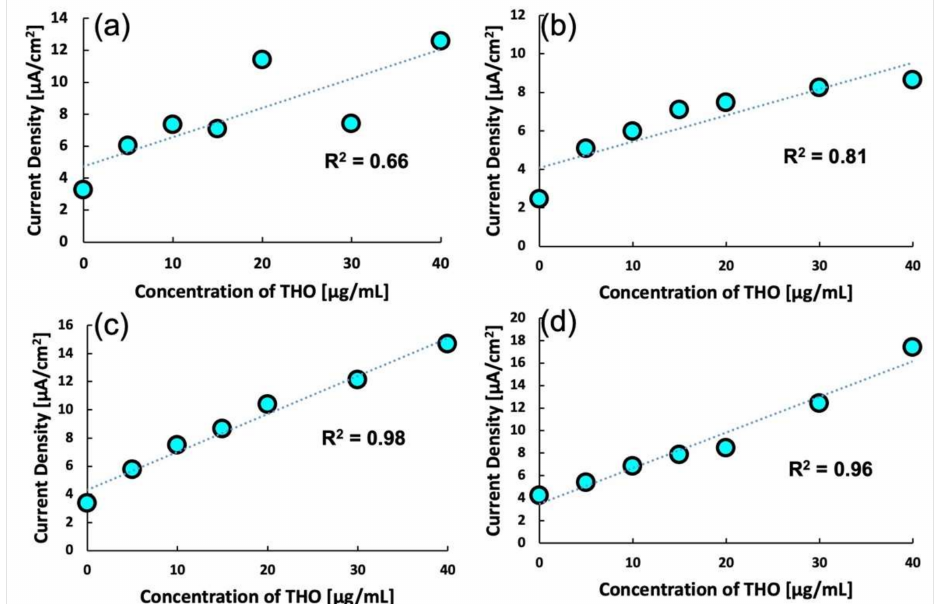
Figure 3. Calibration curves for MIP 3 at various scan rates: ( a ) 5 mV/s, ( b ) 10 mV/s, ( c ) 20 mV/s, and ( d ) 50